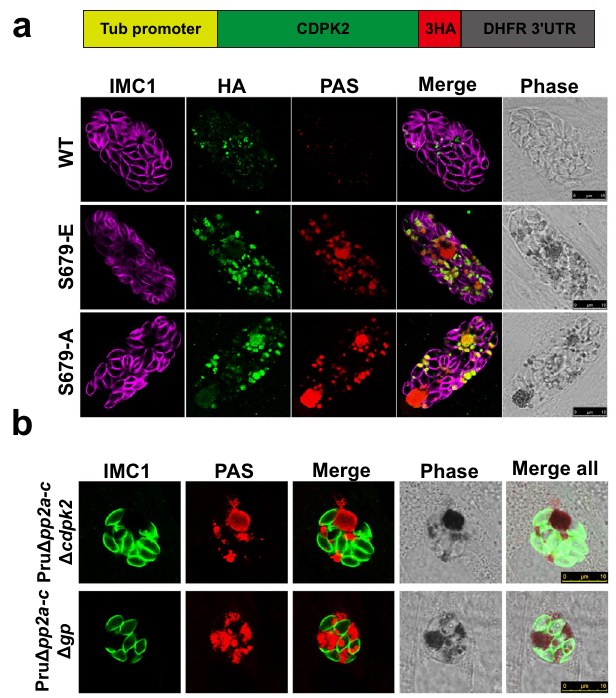
Fig. 7 | Dephosphorylation of CDPK2 is essential for the regulation of starch metabolism. a PAS staining of Pru Δ cdpk2 tachyzoites expressing the wild-type or phosphomimeticmutantversionofCDPK2fusedwith3HAtagsundercontrolof β - tubulin promoters and normal culture conditions. The amylopectin was stained with PAS (red), the tagged protein was detected using α -HA antibody (green) and parasitesweredetectedwithanti-IMC1antibody(magenta).Scalebar,10 µ m. b PAS stainingofthedoubleknockoutsofPru Δ pp2a-c Δ cdpk2 andPru Δ pp2a-c Δ gp strains. The amylopectin was stained with PAS (red), followed by immuno fl uorescence detection of parasites with anti-IMC1 antibody (green). Scale bar, 10 µ